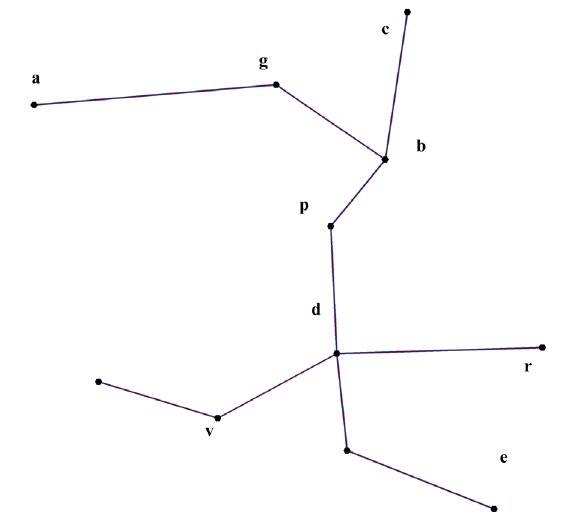
Fig. 7. Defined network structure for roads